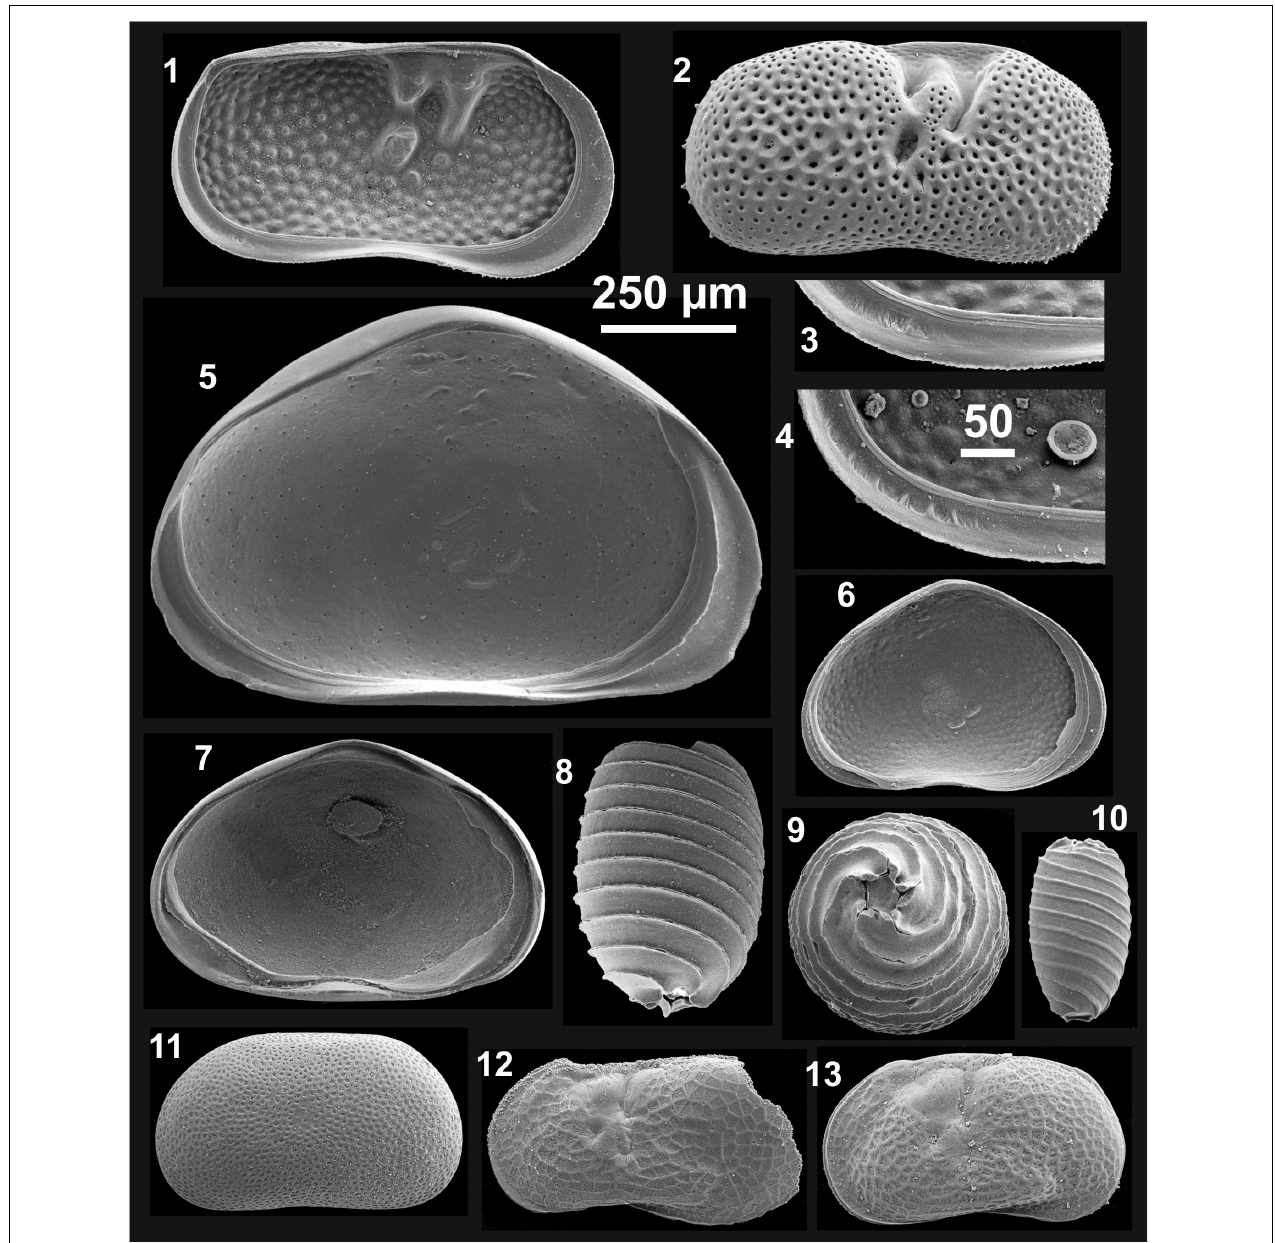
FIGURE 4 | Recorded fossils from Lake Ulaan. 1 Ilyocypris cf. inermis left valve (LV) internal view (iv); 2 I. gr. inermis right valve (RV) external view (ev); 3 I. cf. inermis , marginal ripplets on posteroventral part of inner lamella; 4 Ilyocypris cf. bradyi , marginal ripplets on posteroventral part of inner lamella; 5 Heterocypris salina LV iv;